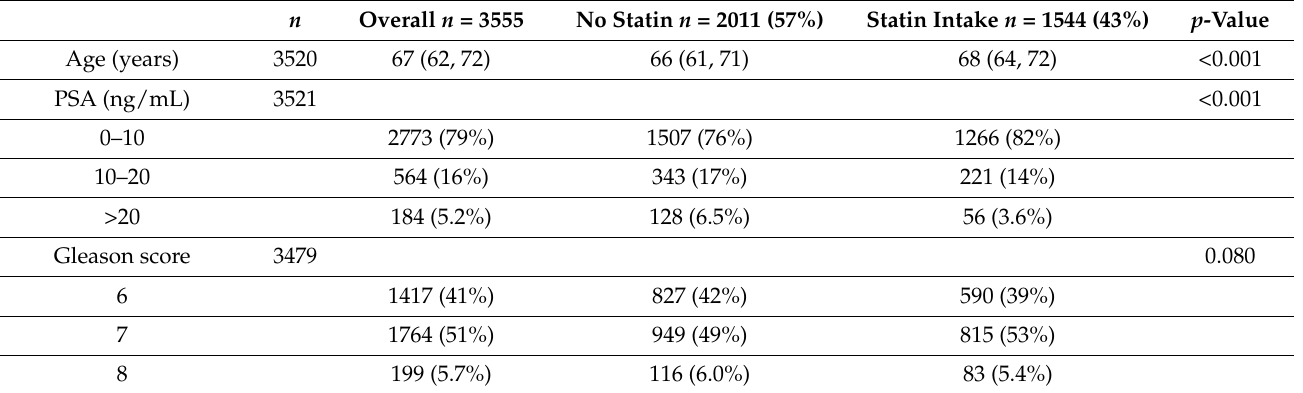
Table 1. Patient and clinicopathological characteristics tabulated according to statin use. All values are medians (IQR) or frequencies